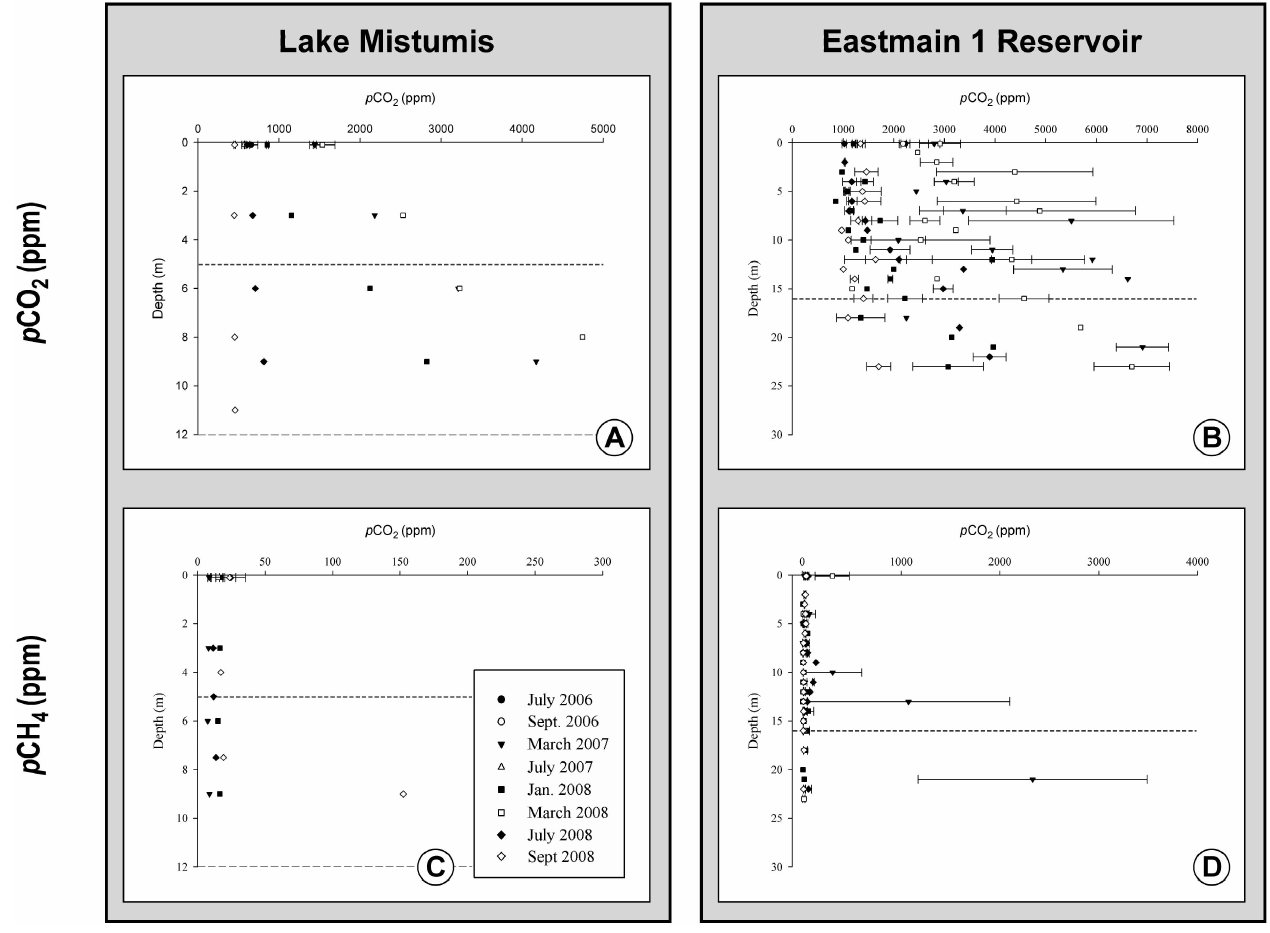
Fig. 4. Mean profiles of p CO 2 and p CH 4 for Eastmain 1 reservoir and Mistumis Lake. Bars represent standard errors. Dashed lines represent maximum depth (for Mistumis Lake) and dotted lines represent mean depth.